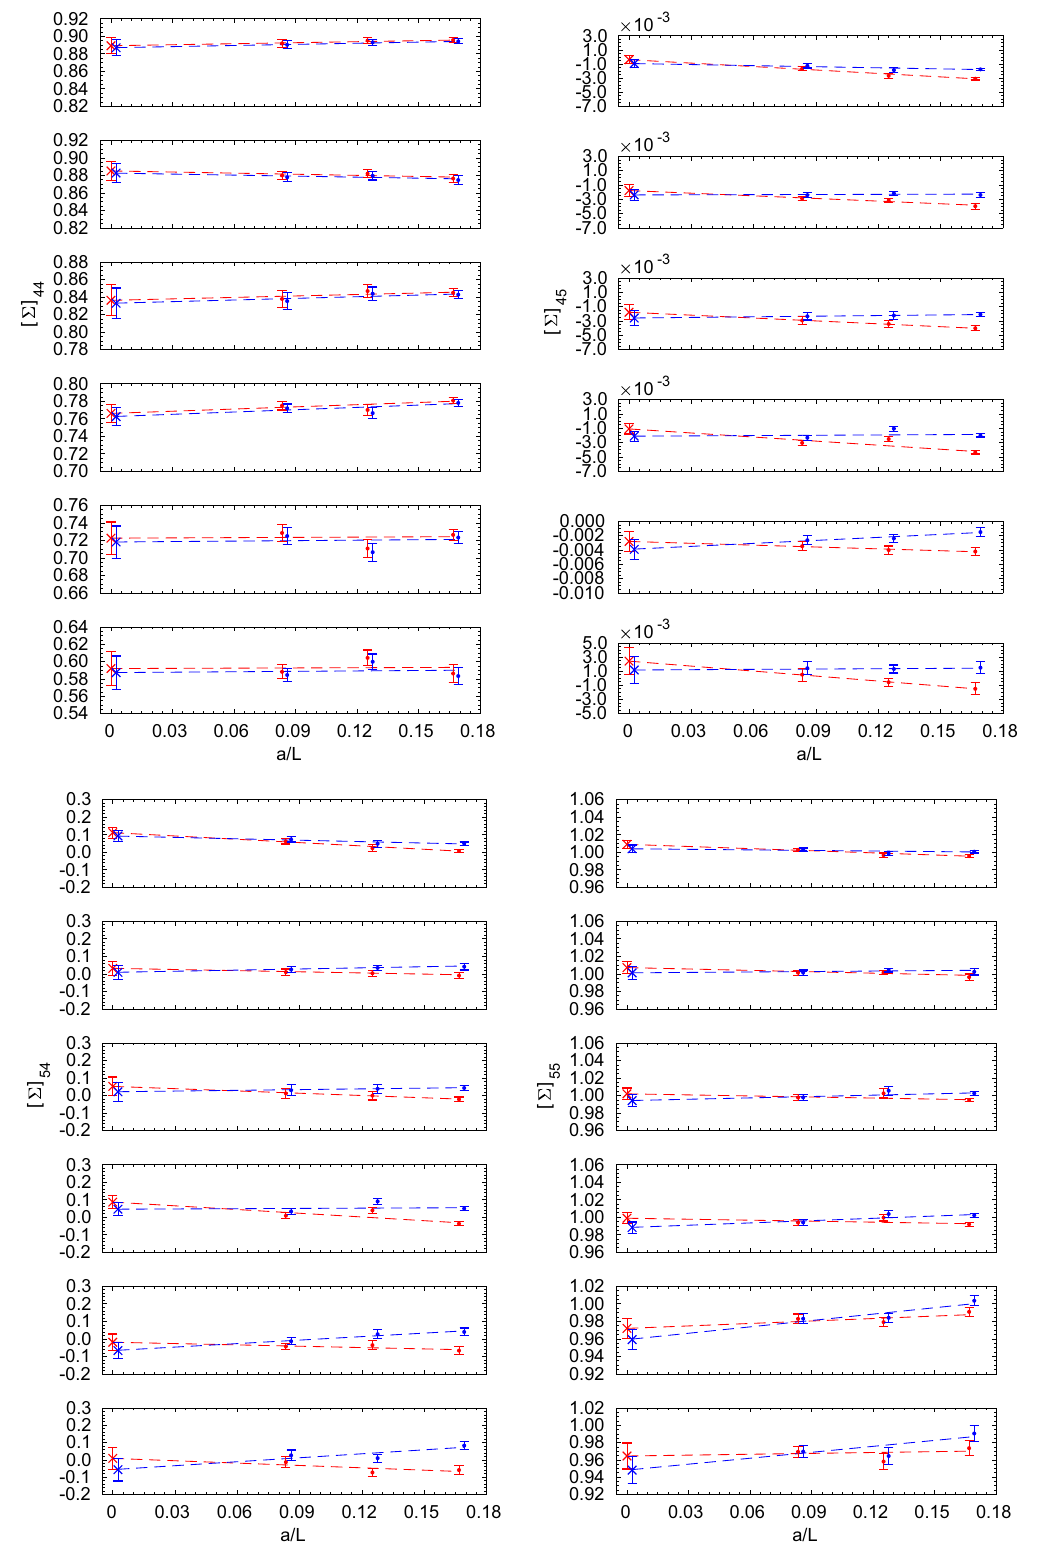
− ( u , a / L ) inblue,oftheoperatorbasis { Q −